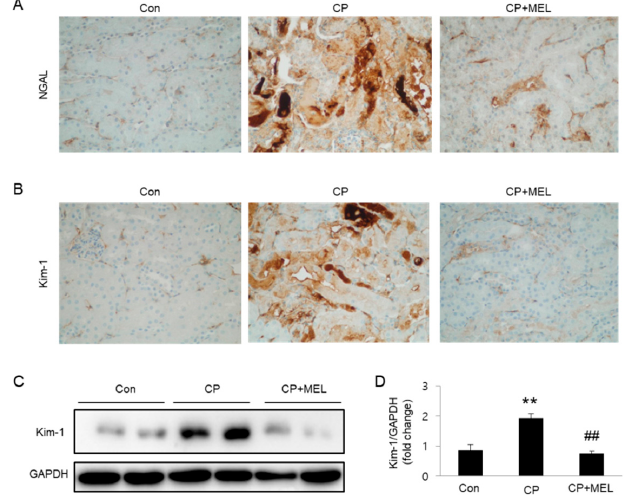
Figure 3. Effects of melatonin (MEL) on expression of tubular injury markers in mice treated with cisplatin (CP). Representative images of immunohistochemical staining using anti-neutrophil gelatinase-associated lipocalin (NGAL) ( A ) or anti-kidney injury molecule-1 (Kim-1) antibody ( B ). Scale bar: 25 μ m. ( C ) Western blots of Kim-1 level in kidneys. ( D ) Quantification of Kim-1 level. ** P < 0.01 vs. Con. ## P < 0.01 vs. CP.